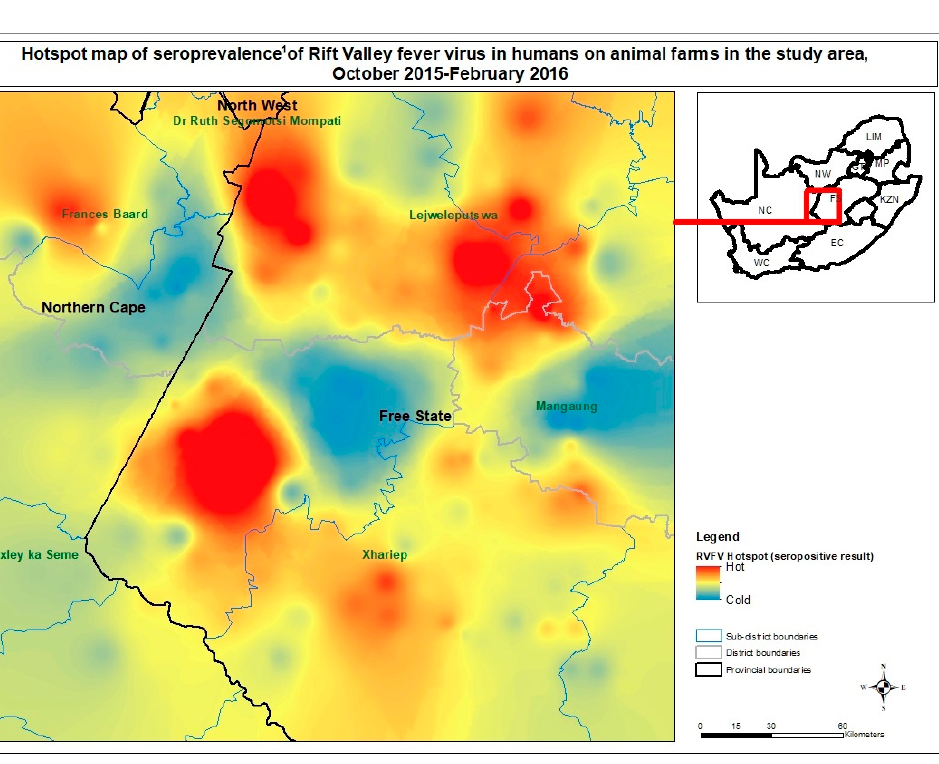
Figure 1. Distribution of anti–Rift Valley fever virus antibodies in 462 humans on 189 ruminant livestock and game farms in the study area in central South Africa, sampled during 2015–2016.